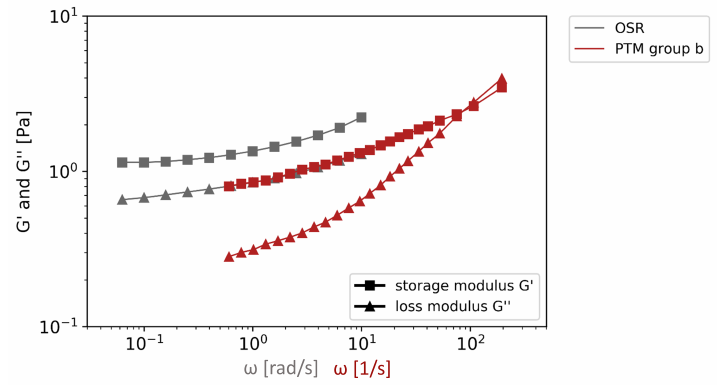
Figure 6. Comparison of the mean viscoelasticity of all OSR measurements and the mean of PTM measurements, group